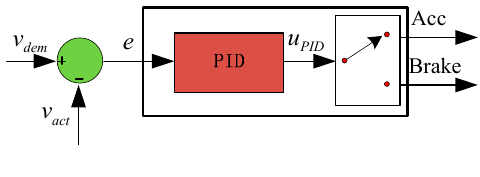
Figure 7. The driver model.